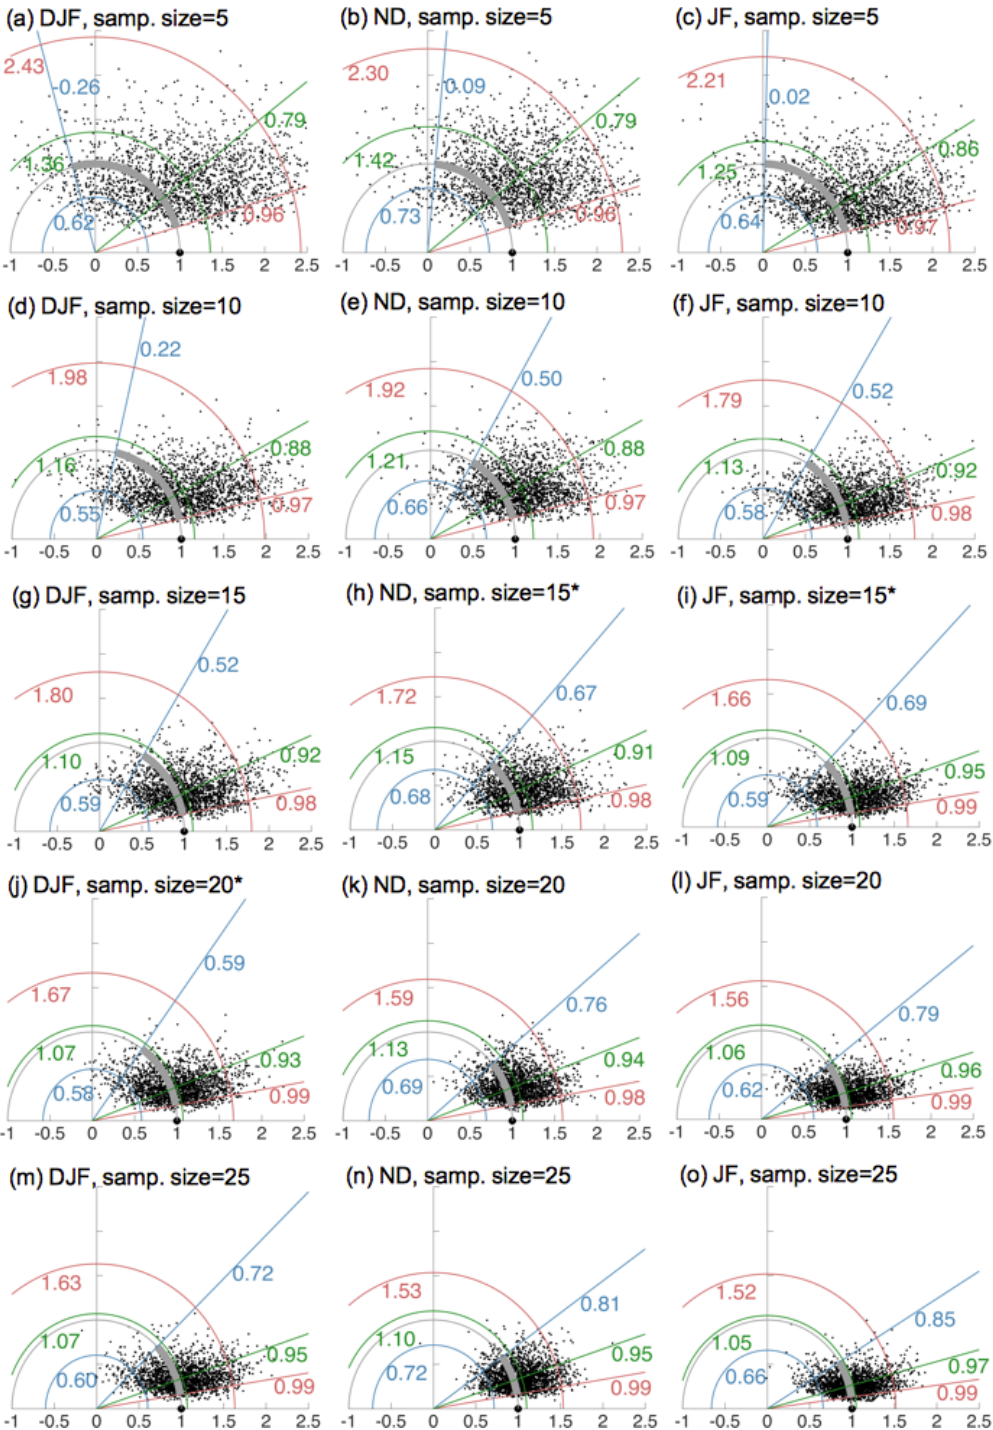
Figure A3. Each panel shows a Taylor diagram for the North Atlantic with 2000 bootstrap SLP composites, of which each has a sample size shown in the panel title. Each sample is bootstrapped (subsampling with replacements) from events in 1870–2014 (Table 1). These panels correspond to the second row of Fig. A2 except for different sample sizes. Panels (j) , (h) , and (i) indicate the estimated minimum sample sizes required for robust signals for spatial patterns of the composites. See Sect. 3.1 for more